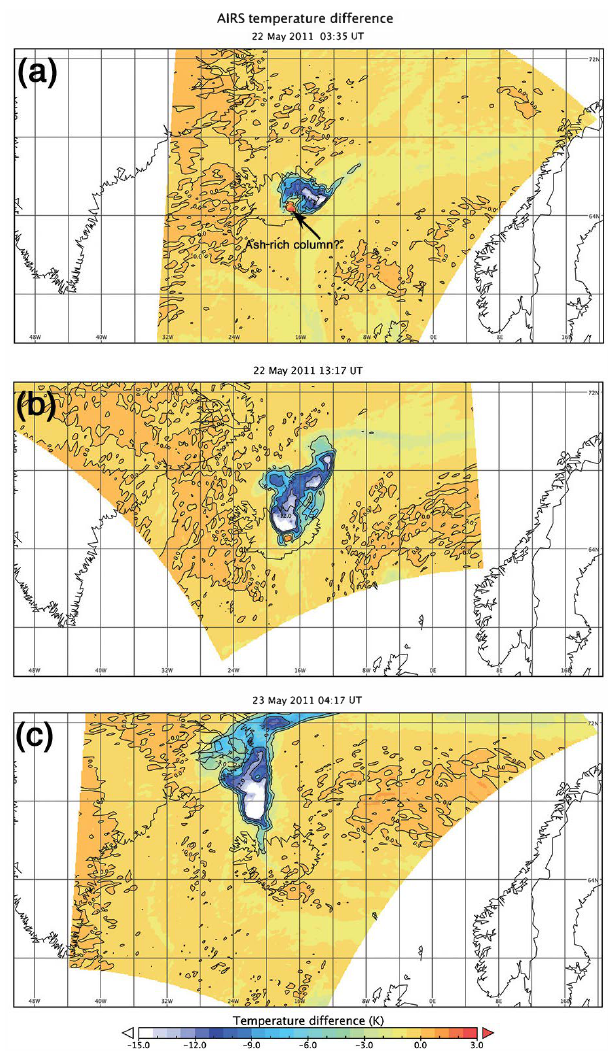
Figure 3. AIRS brightness temperature difference images for over- passes on 22 and 23 May 2011. Panel (a) shows 03:35UTC, 22 May. Panel (b) shows 13:17UTC, 22 May. Panel (c) shows 04:17UTC, 23 May. Negative values suggest absorption by SO 2 gas. The red-coloured spot (positive temperature differences) seen in panels (a) and (b) situated near the Grímsvötn vent may be due to the ash-rich